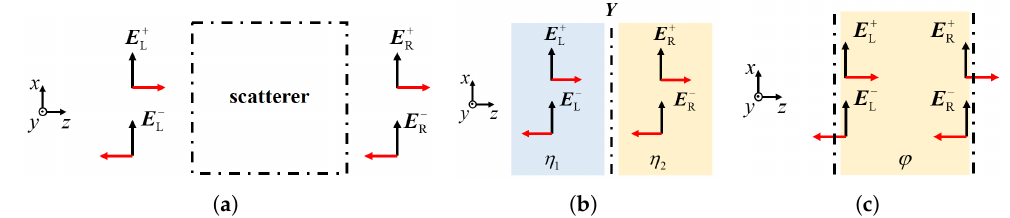
Figure 10. An illustration of the wave matrix and the constitutive blocks of the cascaded structure. ( a ) The definition of a wave matrix. ( b ) A metasurface interface between two dielectric media. ( c ) A dielectric